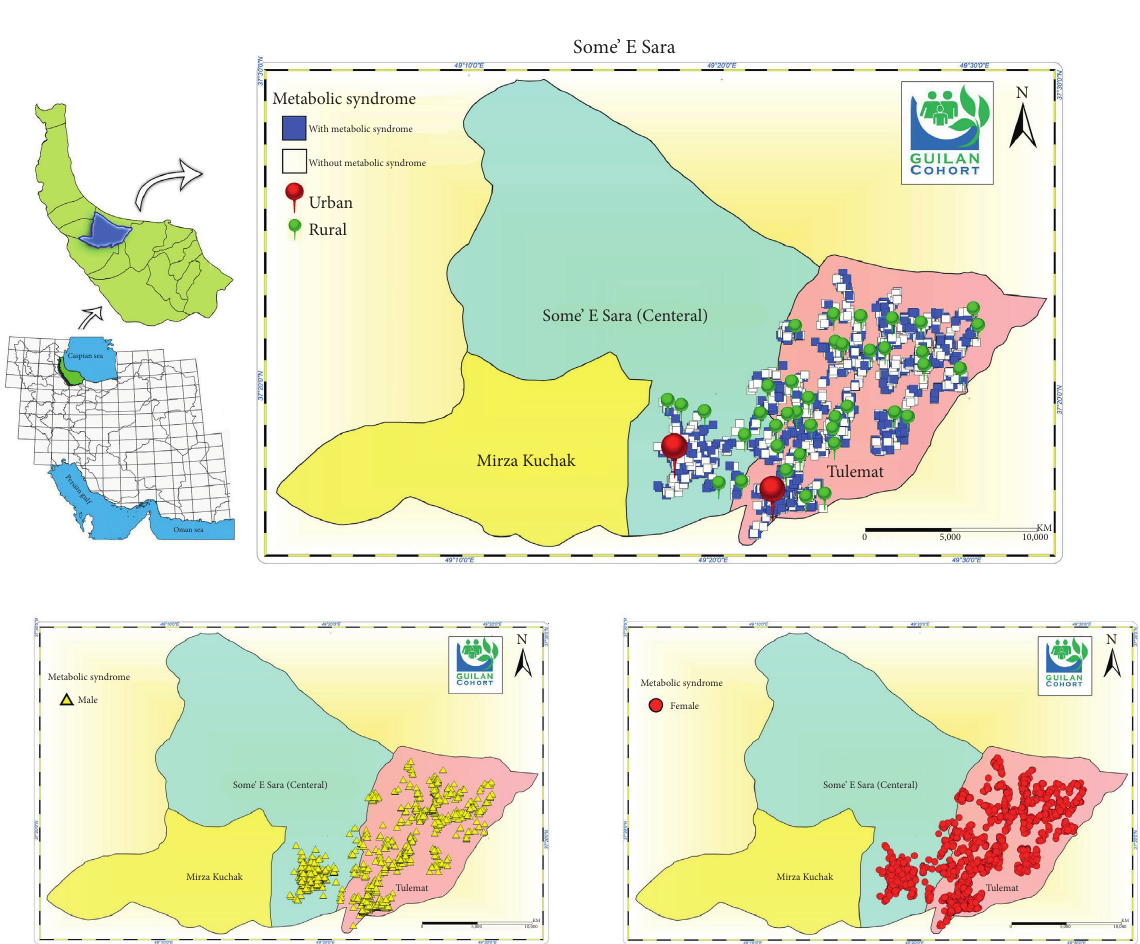
Figure 1: Geographic distribution of metabolic syndrome based on IDF definition in Some’e Sara (derived from our own work).